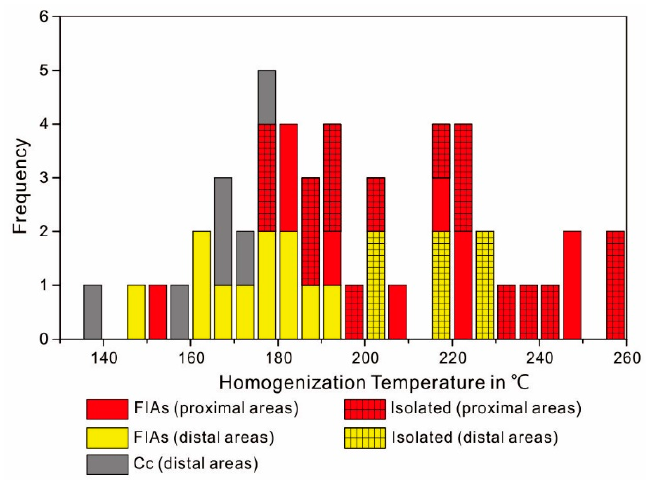
Figure 10. Histograms of homogenization temperatures of fluid inclusion assemblages (FIA) and isolated fluid inclusions.